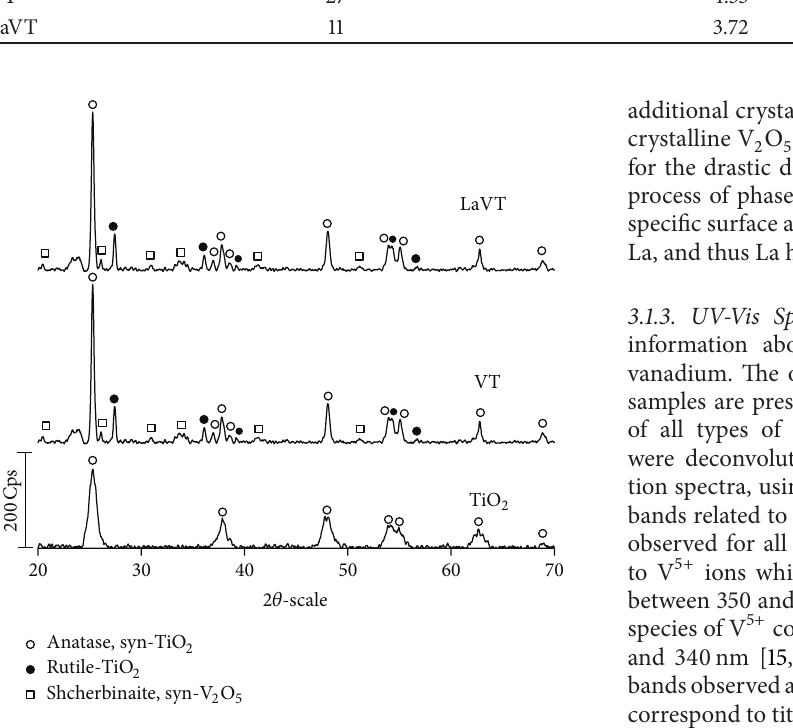
plane of anatase phase is clearly observed in all